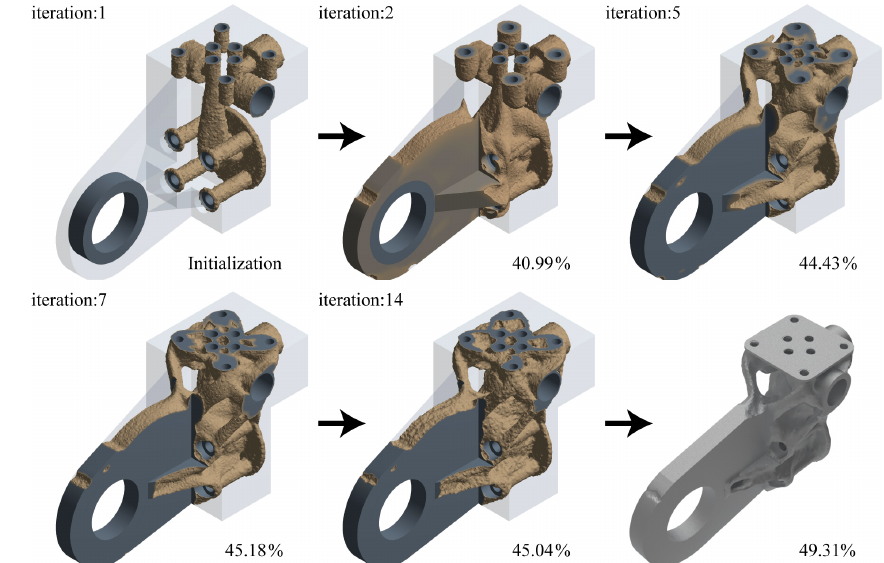
Figure 9. Topology-optimized pull model.